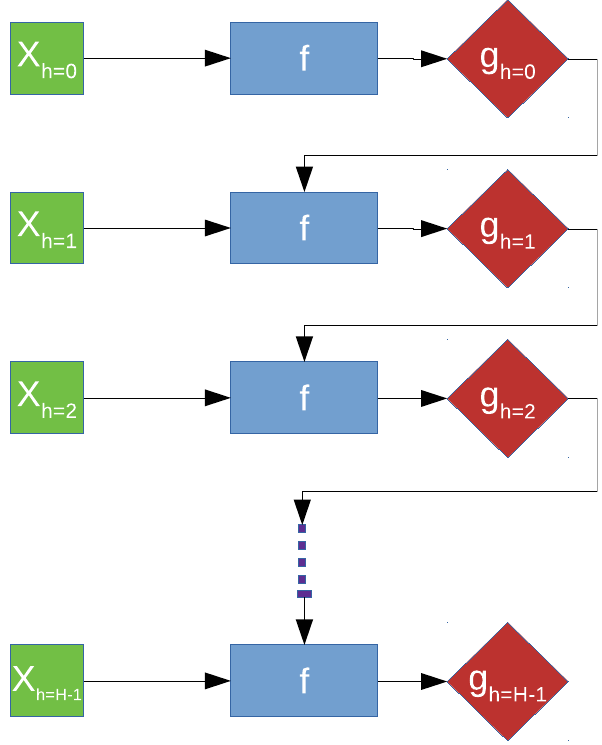
Figure 8. Recursive approach to time series